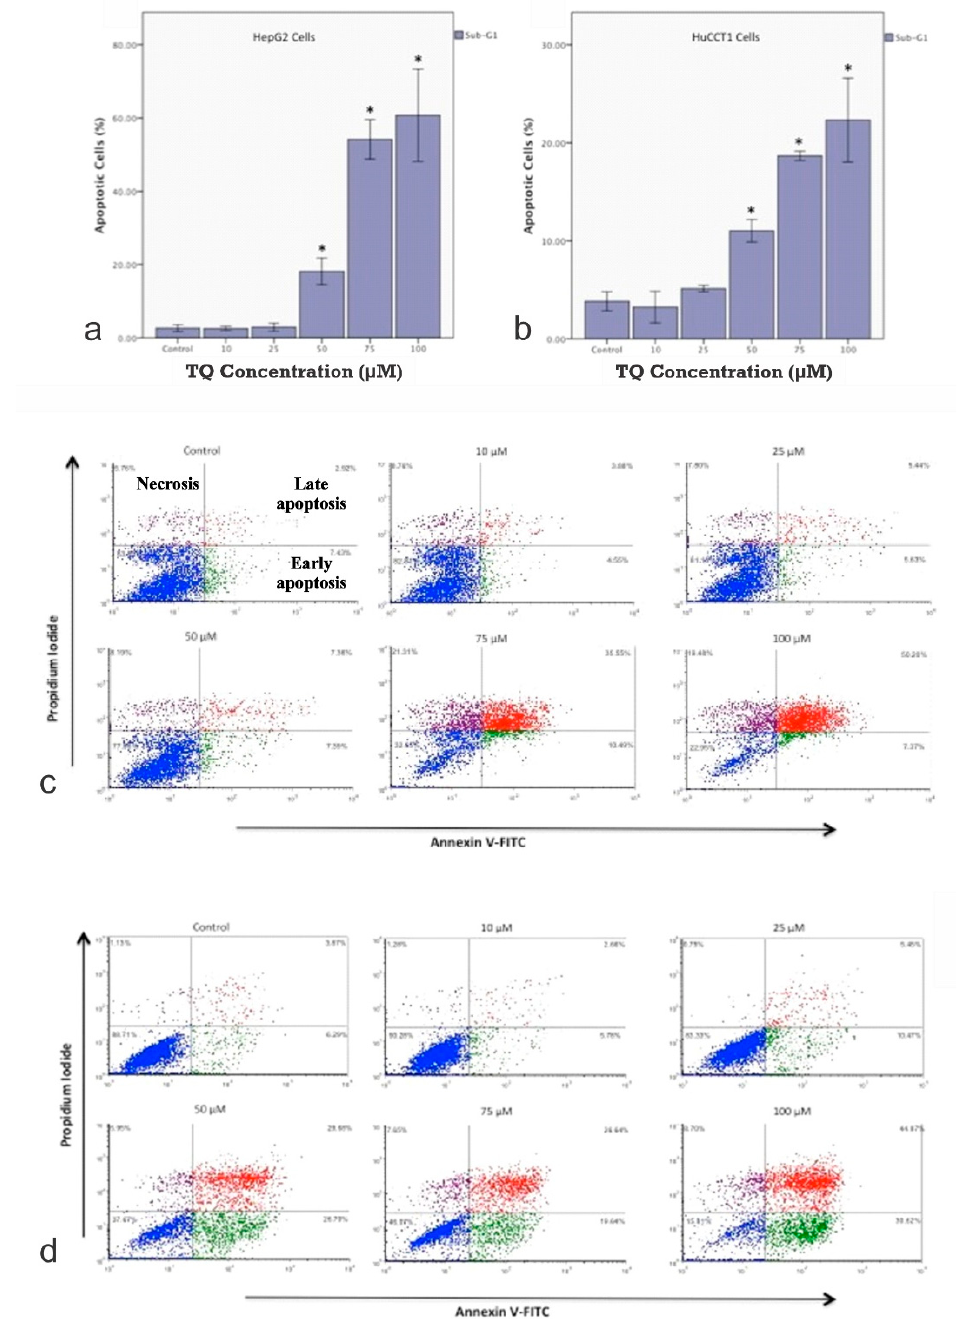
Figure 5. ( a , b ) Histogram of the distribution of Apoptotic Cells after TQ Treatment. ( c ) Flow cytometric plots of FITC Annexin V/PI staining of HepG2 cell lines. ( d ) Flow cytometric plots of FITC Annexin V/PI staining of HuCCT1 cell lines. Here, the flow cytometric plots of FITC Annexin V/PI staining of (A) HepG2 and (B) HuCCT1 cell lines (experiments performed in triplicate) are shown. Annexin V is a Ca2+-dependent phospholipid-binding protein, which can bind to phosphatidylserine (PS) protein that externalizes from the inner membrane to the outer surface of the plasma membrane of cells undergoing apoptosis. Annexin V is used in combination with PI dye to distinguish early from late apoptotic cells. Live cells have intact plasma membranes that exclude PI, whereas the membranes of damaged cells are permeable to PI (*: p < 0.05). As described above, HepG2 and HuCCT1 cell lines were treated with increasing concentrations of TQ for 24 h followed by Annexin V/PI staining. The representative dot